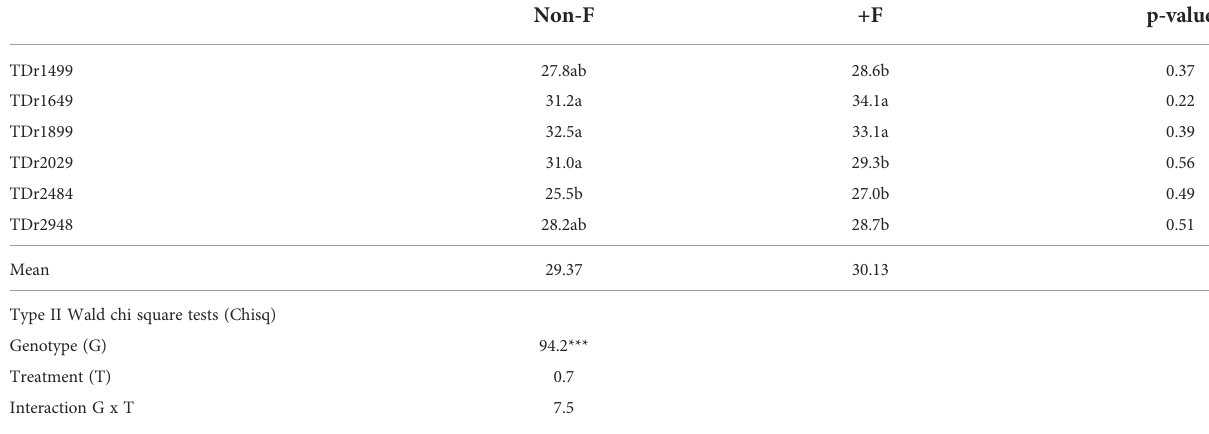
TABLE 4 Effect of genotype and fertilizer treatment on percent dry matter content of tuber (%) in six white Guinea yam ( Dioscorea rotundata ) genotypes in the 2018